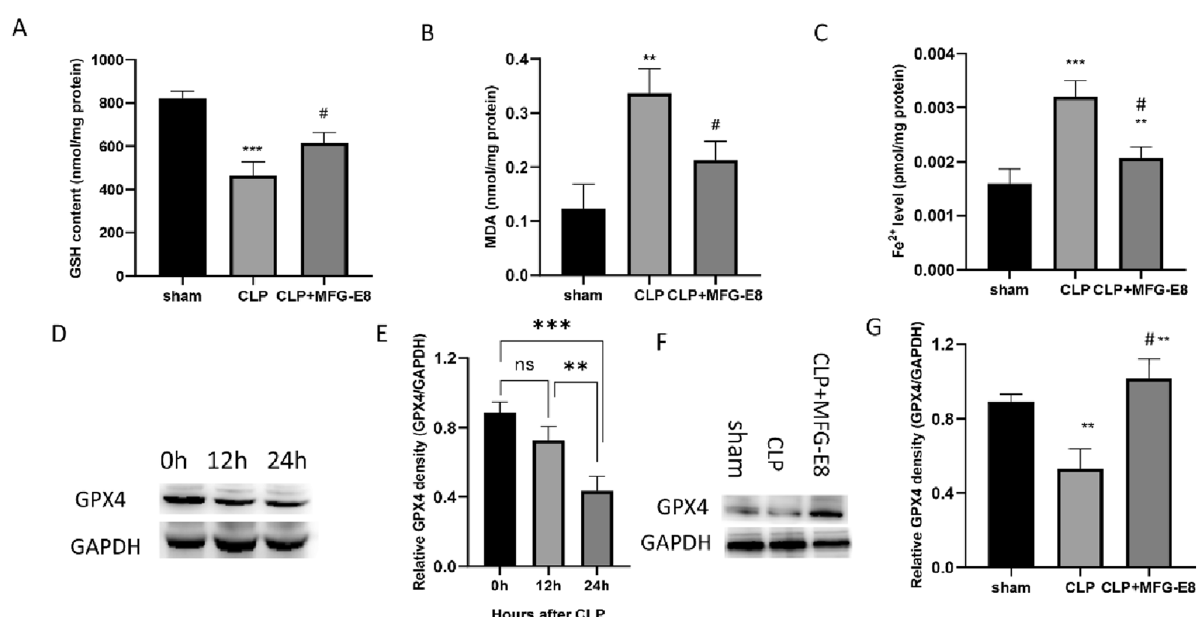
Figure 5. MFG-E8 suppressed ferroptosis in CLP-induced septic mice. Liver glutathione (GSH) contents ( A ), liver malondialdehyde (MDA) contents ( B ) and liver ferrous (Fe 2+ ) concentrations ( C ) were measured 24 h after CLP. ( D,E ) Western blot analysis of GPX4 in the liver of CLP-induced septic mice at 0, 12 and 24 h after CLP. n = 3, mean ± SEM. ( F,G ) Western blot analysis of GPX4 in the liver of CLP-induced septic mice 24 h after CLP with MFG-E8 treatment. n = 3, mean ± SEM. (*p < 0.05 versus sham group; #, *p < 0.05 versus CLP group; *p < 0.05, **p < 0.01, ***p <